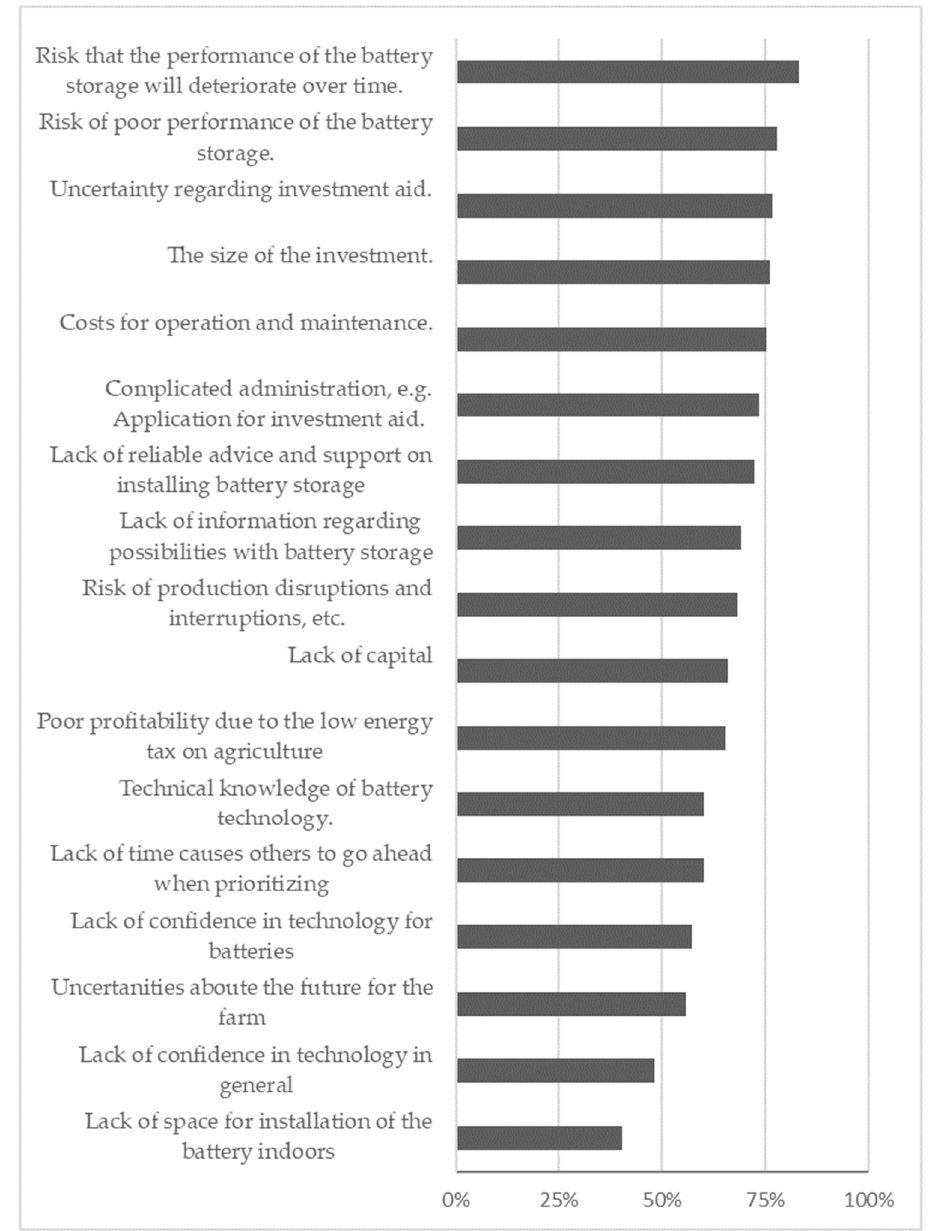
Figure 2. Major barriers to battery storage in PV systems, where 0% corresponds to very low barrier and 100% to very high barrier.